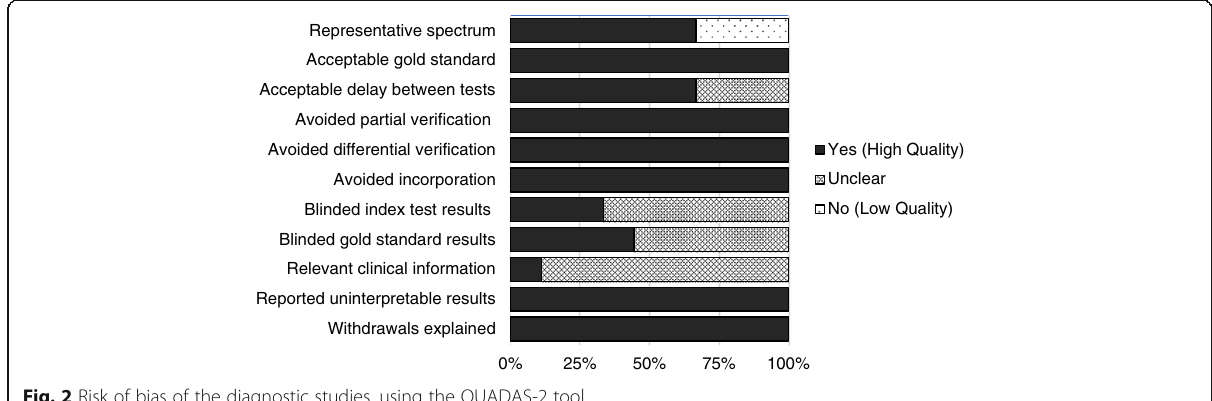
Fig. 2 Risk of bias of the diagnostic studies, using the QUADAS-2